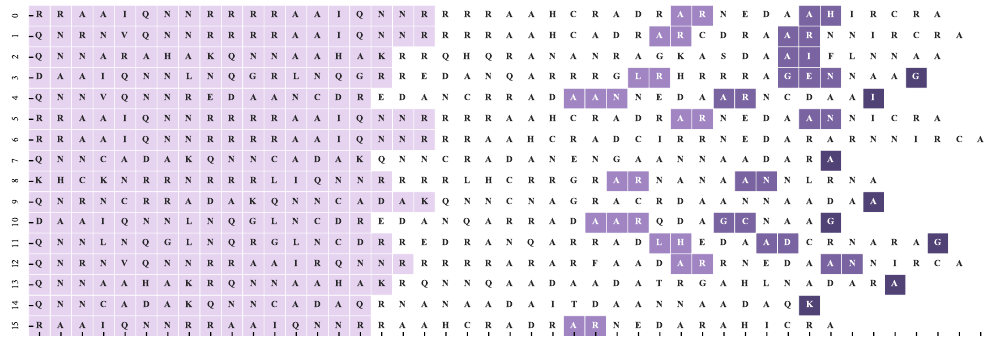
Figure 1. The 15 unaligned sequences of the tune family “Daar ging een heer”. Colours correspond to motif labels. White colour indicates no motif